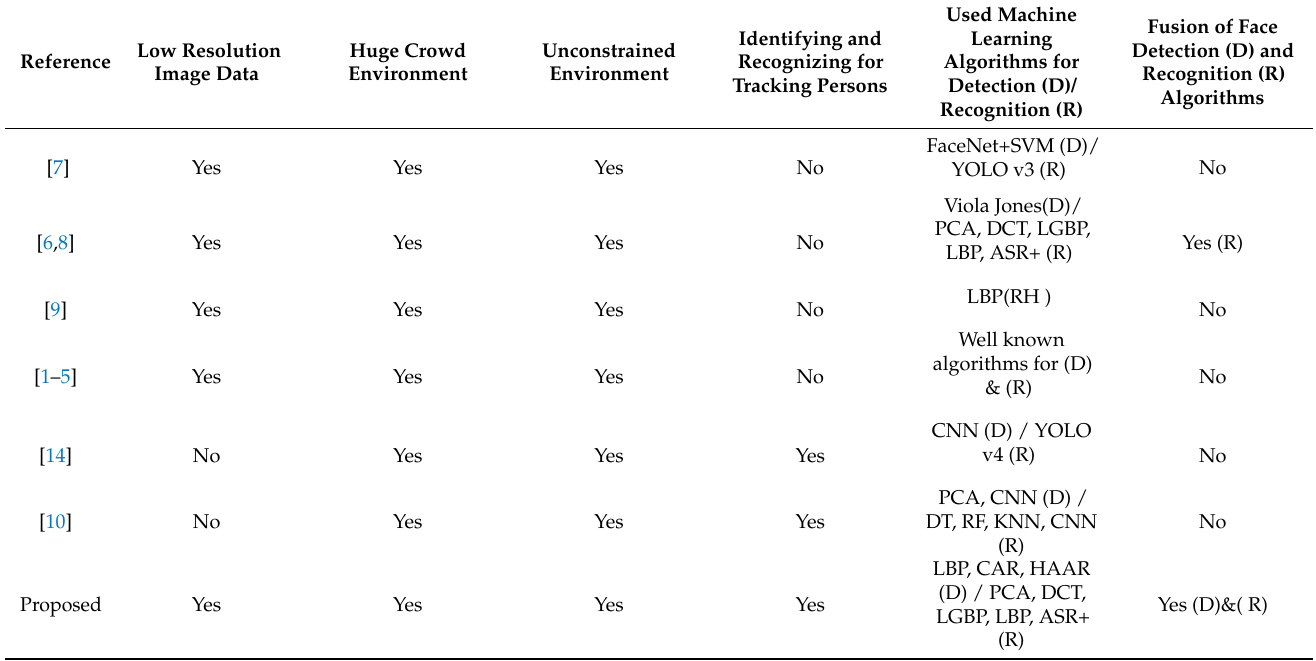
Table 1. Comparison of various parameters used in the problem